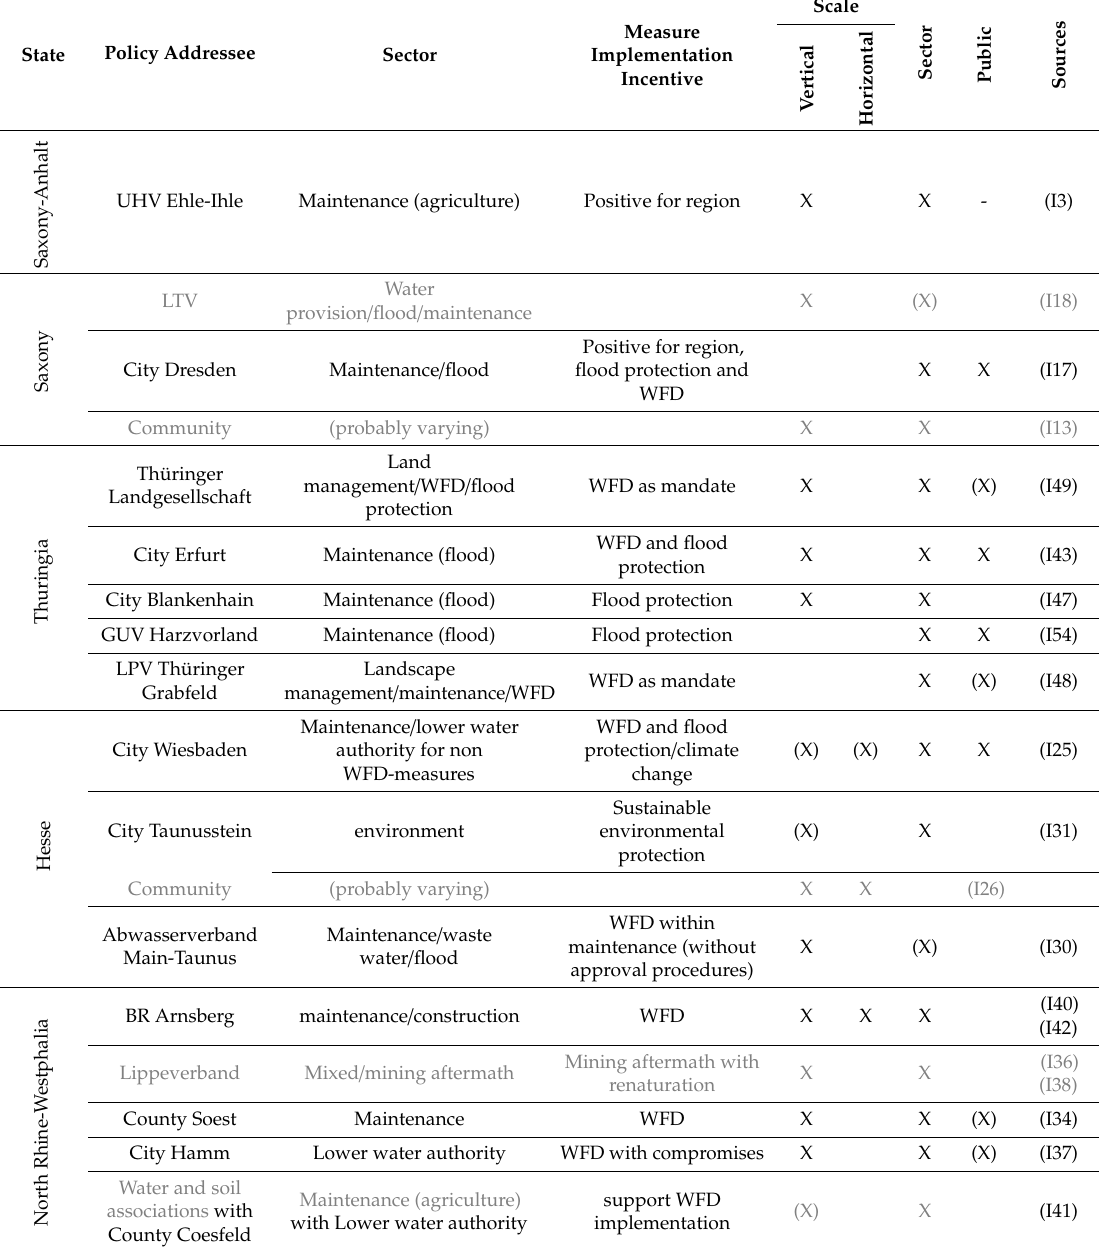
Table 3. Conceptual categorization of integration